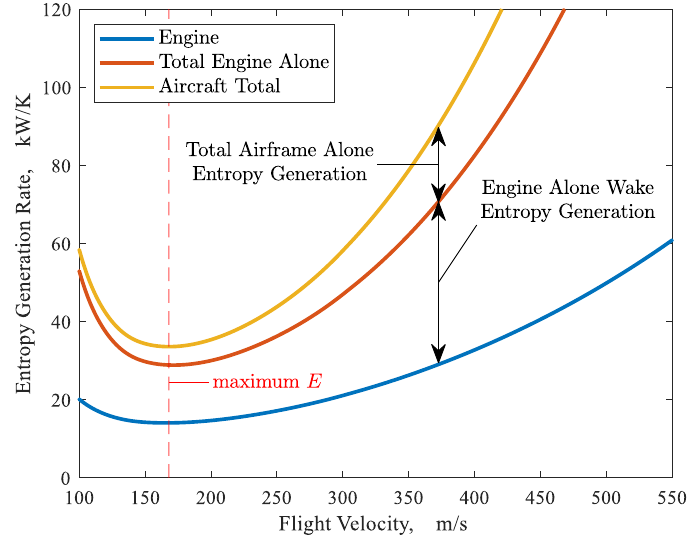
Figure 9. Total aircraft entropy generation rate breakdown over range of flight velocities. F-5E airframe with modelled turbojet engines. Altitude = 9 km. airframe with modelled turbojet engines. Altitude = 9